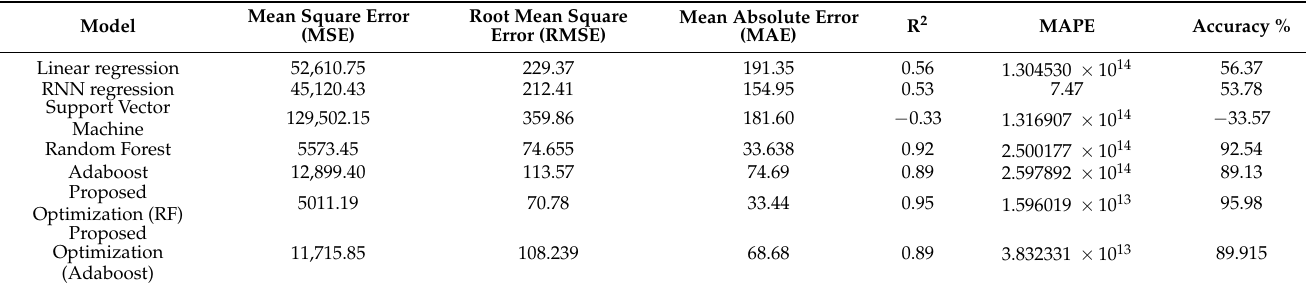
Table 5. Results obtained on Juriquilla, Queretaro dataset for the year 2021.